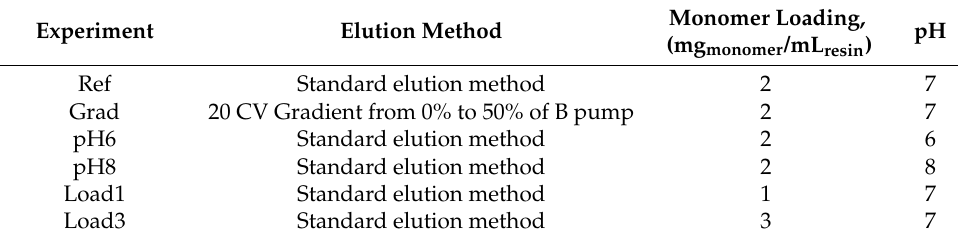
Table 1. Operating conditions of runs performed for the modeling of the industrial process. Experiment